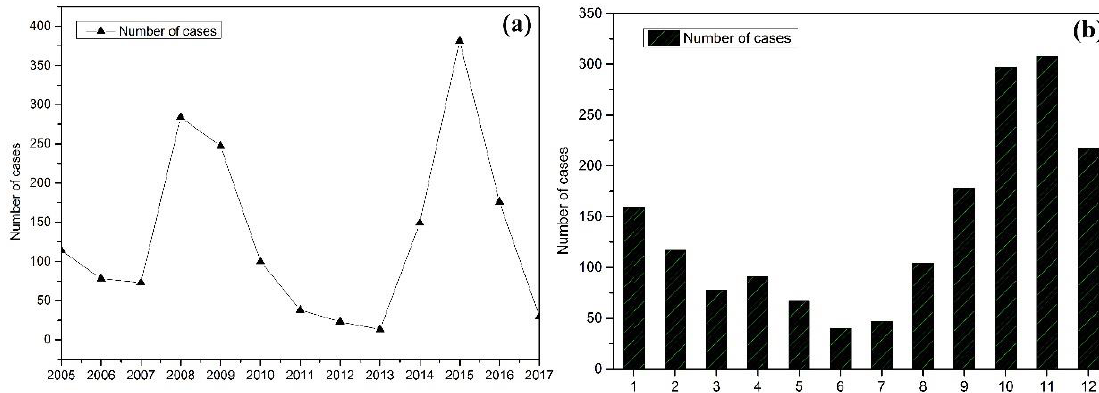
Figure 3. ( a ) Yearly distribution of visceral leishmaniasis (VL) cases from 2005 to 2017 and ( b ) monthly aggregated VL cases incidence.